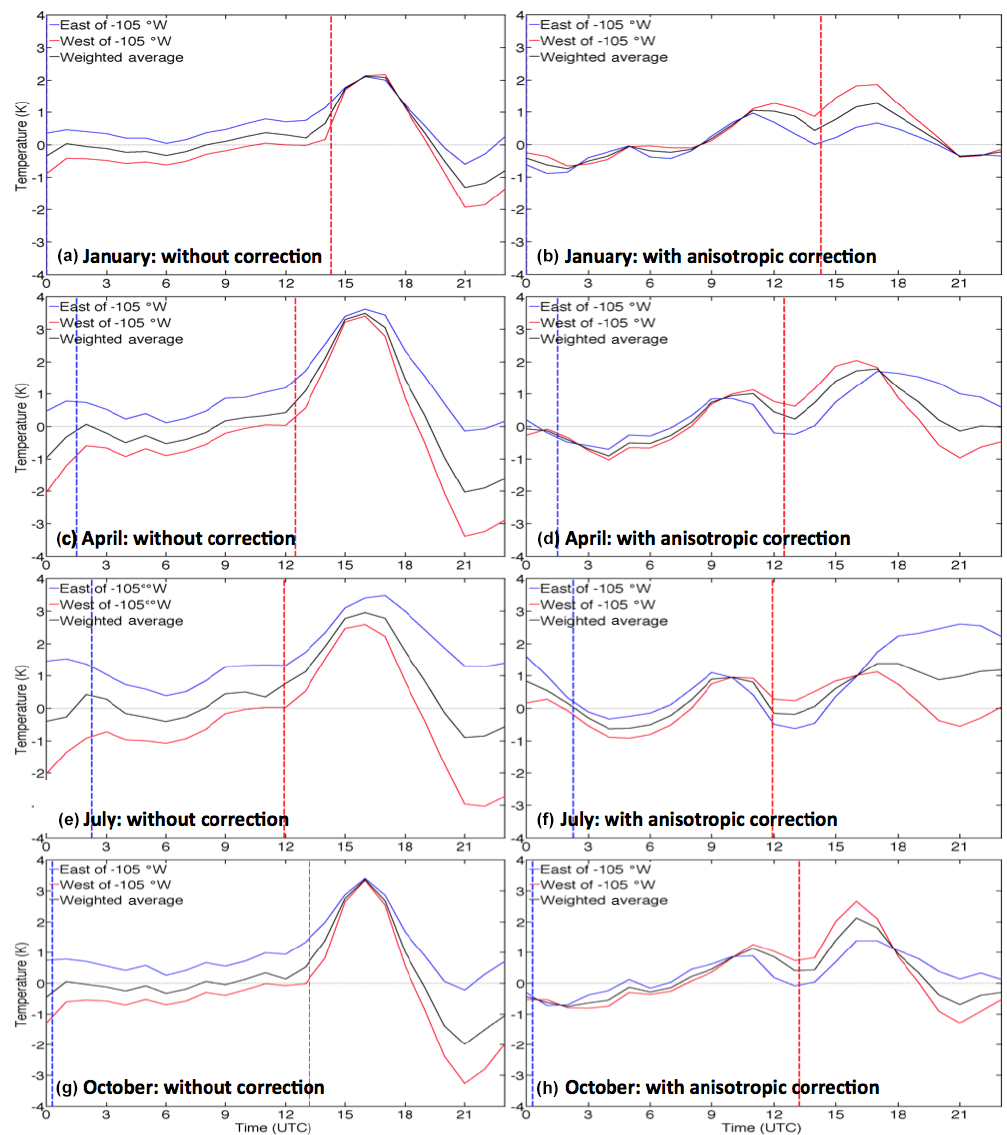
Figure 9. Mean hourly, regional GOES-East–GOES-West LST differences for January, April, July, and October 2013, (left) without and (right) with anisotropic correction. The vertical dashed lines indicate the terminator transitions to night (blue) and day (red) at 37.5 ◦ N, 105 ◦